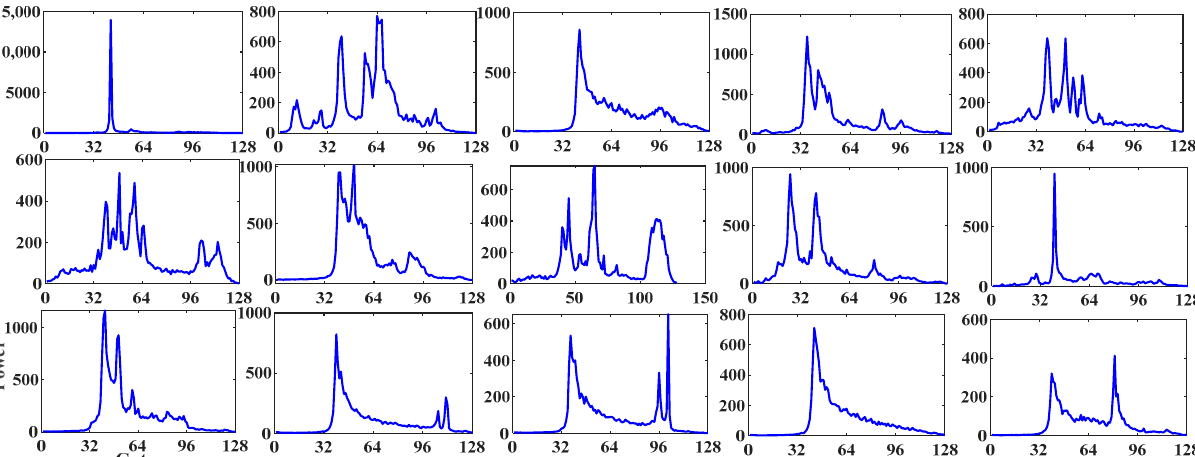
Figure 3. Example of waveforms from pass 25 over the Persian Gulf at 10 km from the coast. The retracked correction (C ret ) is calculated from [37]: